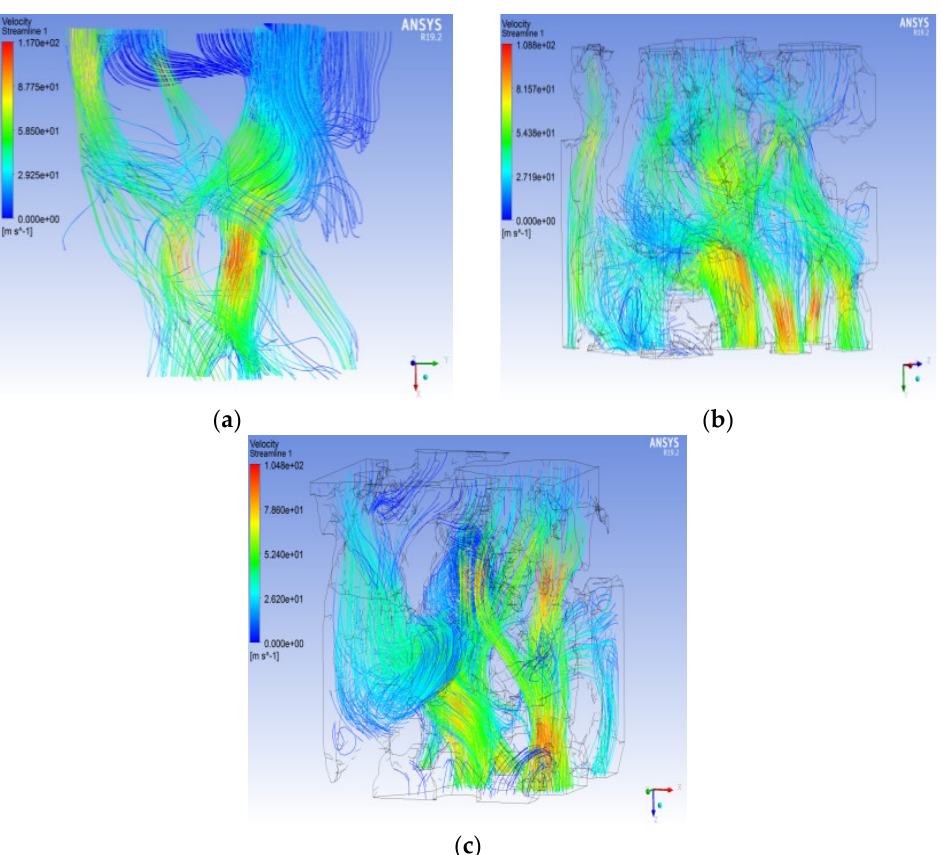
Figure 19. X, Y, and Z negative single channel seepage water pressure distribution diagram. ( a ) X negative direction, ( b ) Y negative direction, and ( c ) Z negative direction.